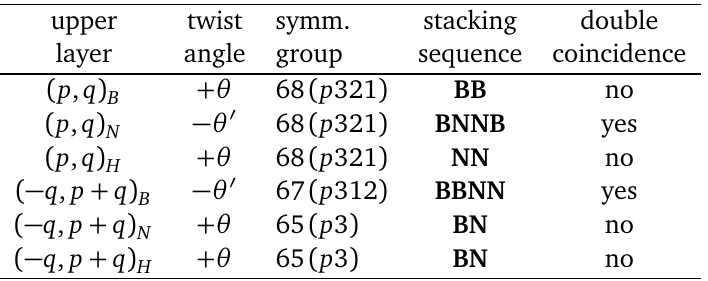
Table 1: The geometry of the five stackings of hBN twisted bilayers. The lower layer is based on the ( q , p ) supercell. B